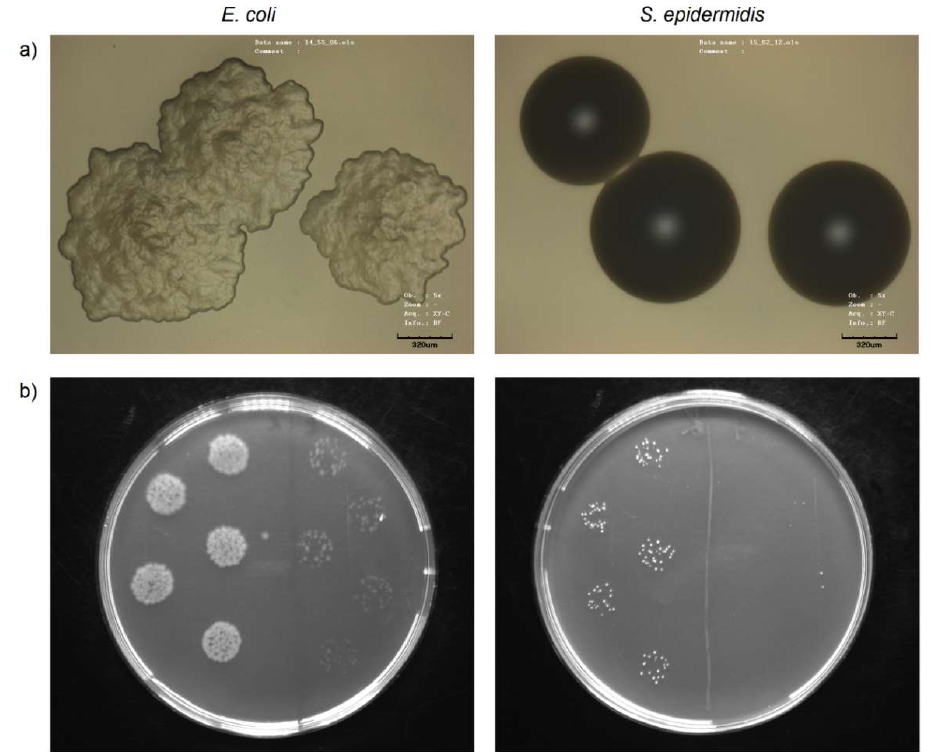
Figure 4. Images of bacterial strains of E. coli and S. epidermidis taken by confocal microscopy ( a ) and growing on agar plates ( b ), before (left) and after (right side of agar plate) the treatment with Ag nanoparticles.